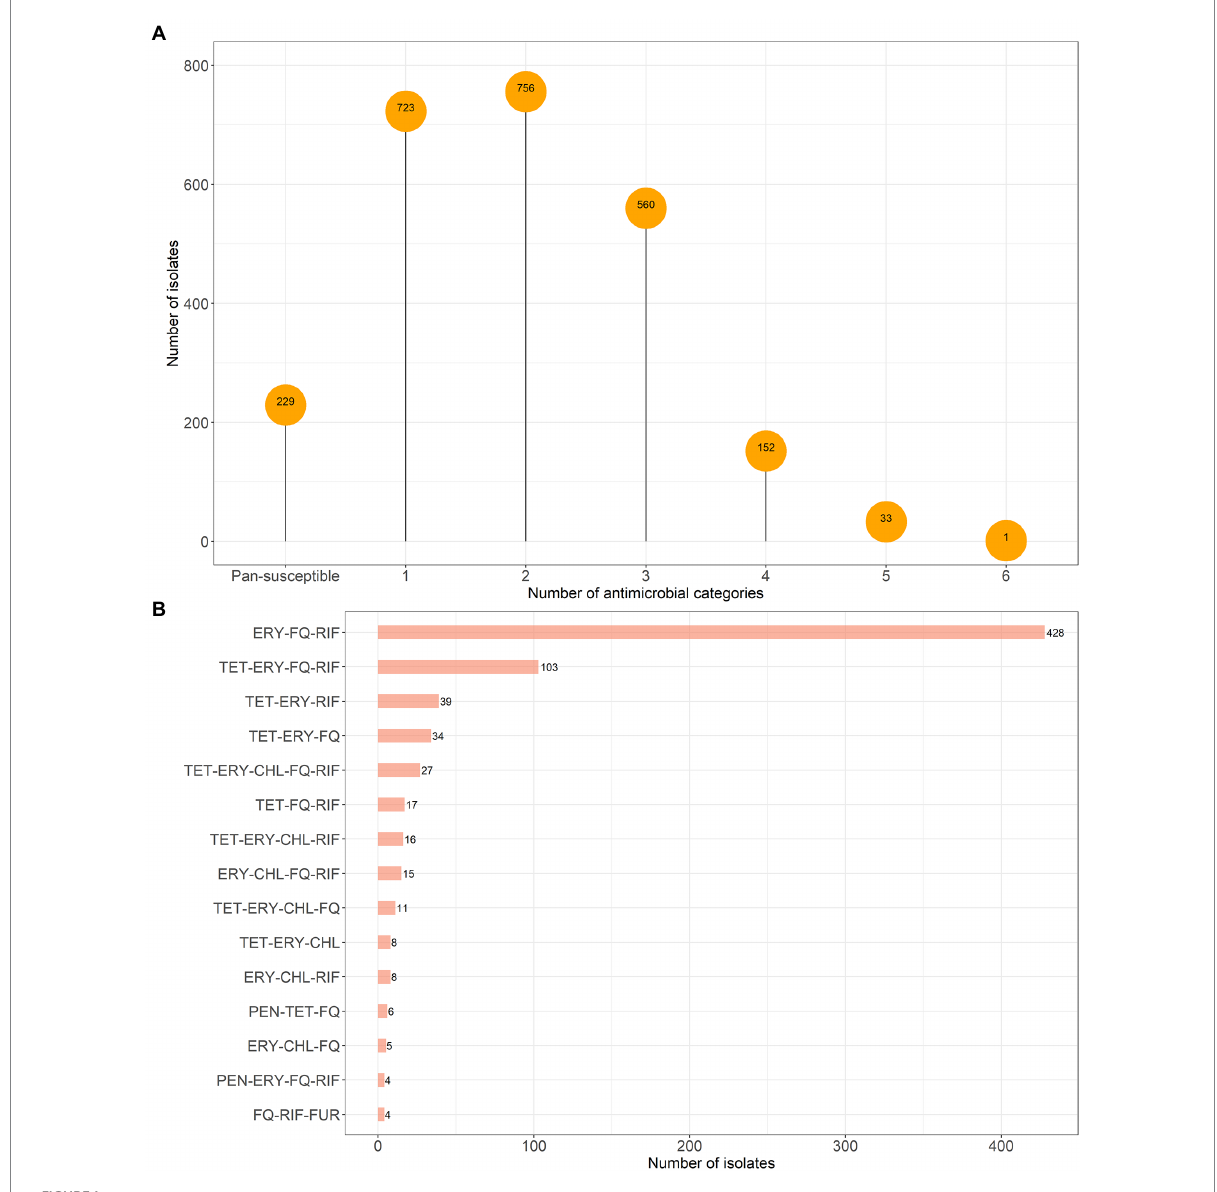
FIGURE 1 Distribution of resistance by number of antimicrobial categories (A) and most 15 common multidrug resistance patterns among Enterococcus faecalis isolates (B) , in canine clinical infections at the Cornell University Animal Health Diagnostic Center (AHDC), 2007–2020. Antimicrobial category abbreviations are listed in Table